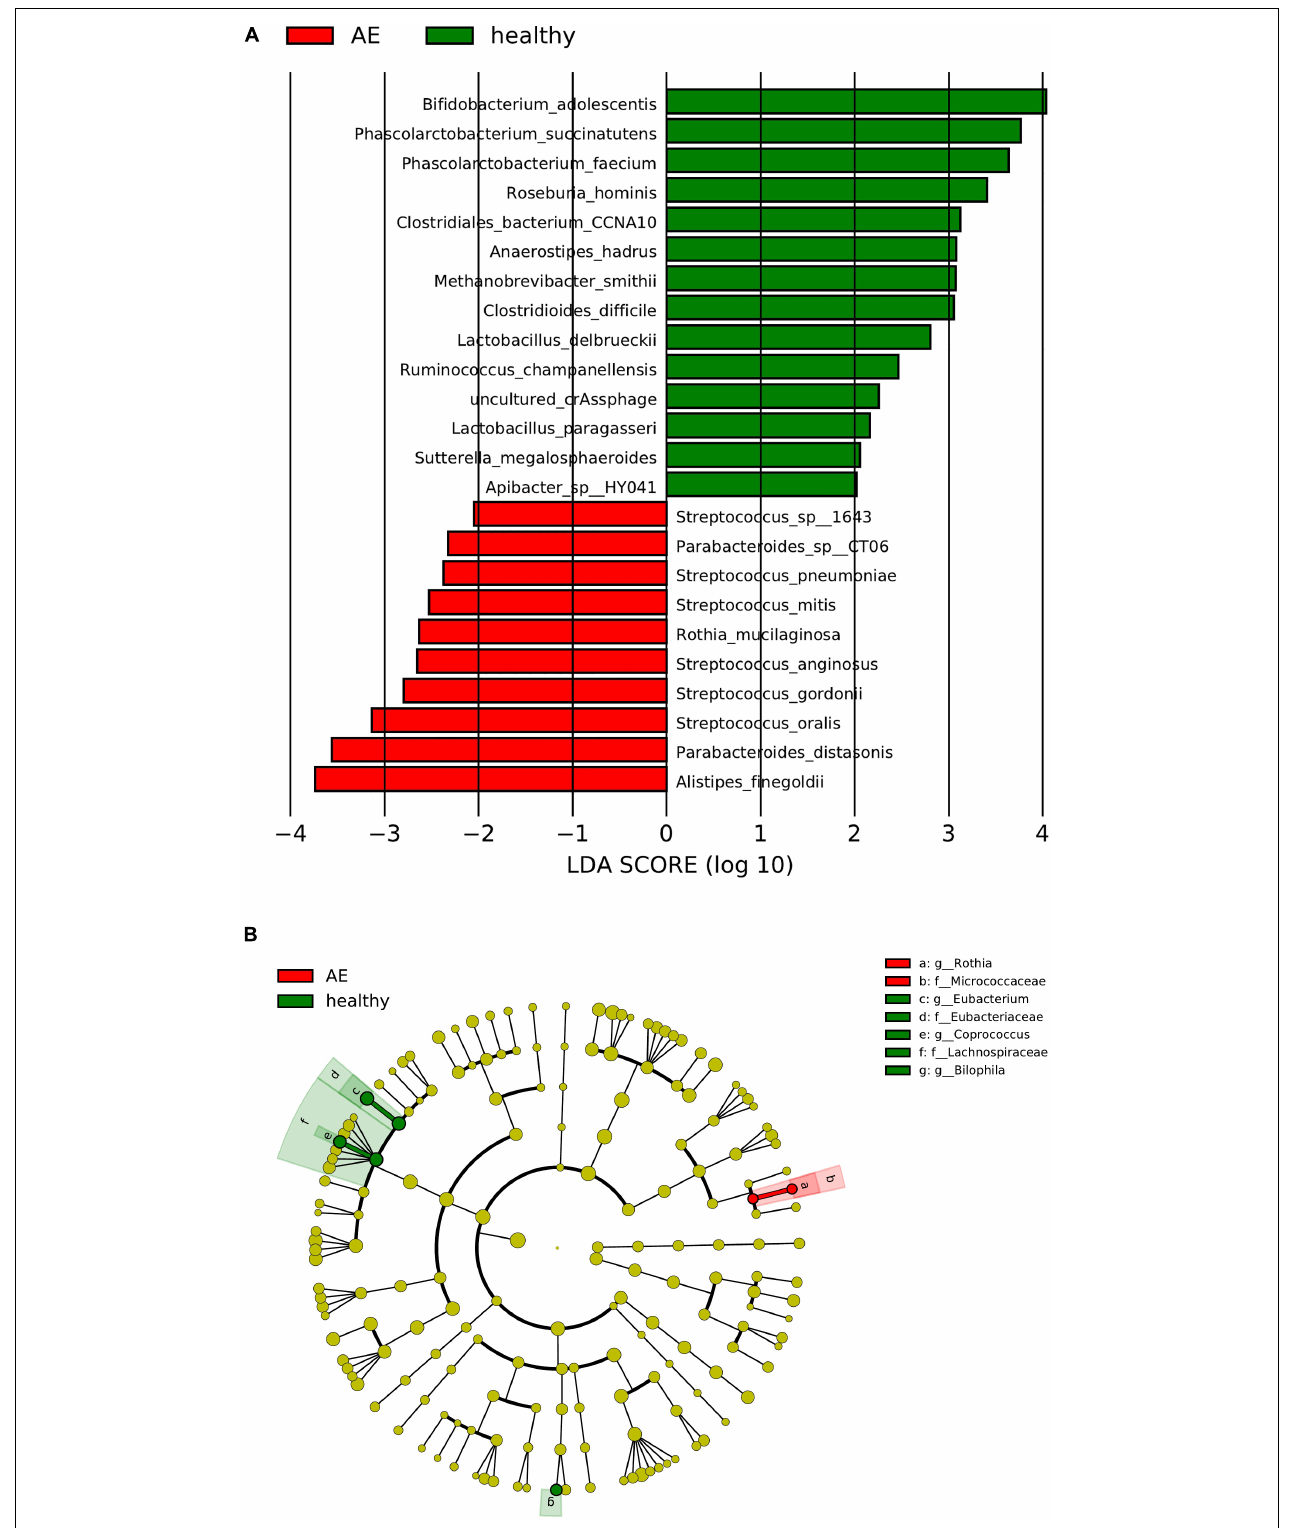
FIGURE 4 | Panel (A) is the histogram of distribution with linear discriminant analysis (LDA) value ≥ 2. Panel (B) shows the evolutionary cladogram. Histogram of LDA effect size (LEfSe) value distribution and evolutionary clade between patients with CE and healthy individuals. g, genus; f, family; s, species; o, order. The meaning of the picture is the same as the one